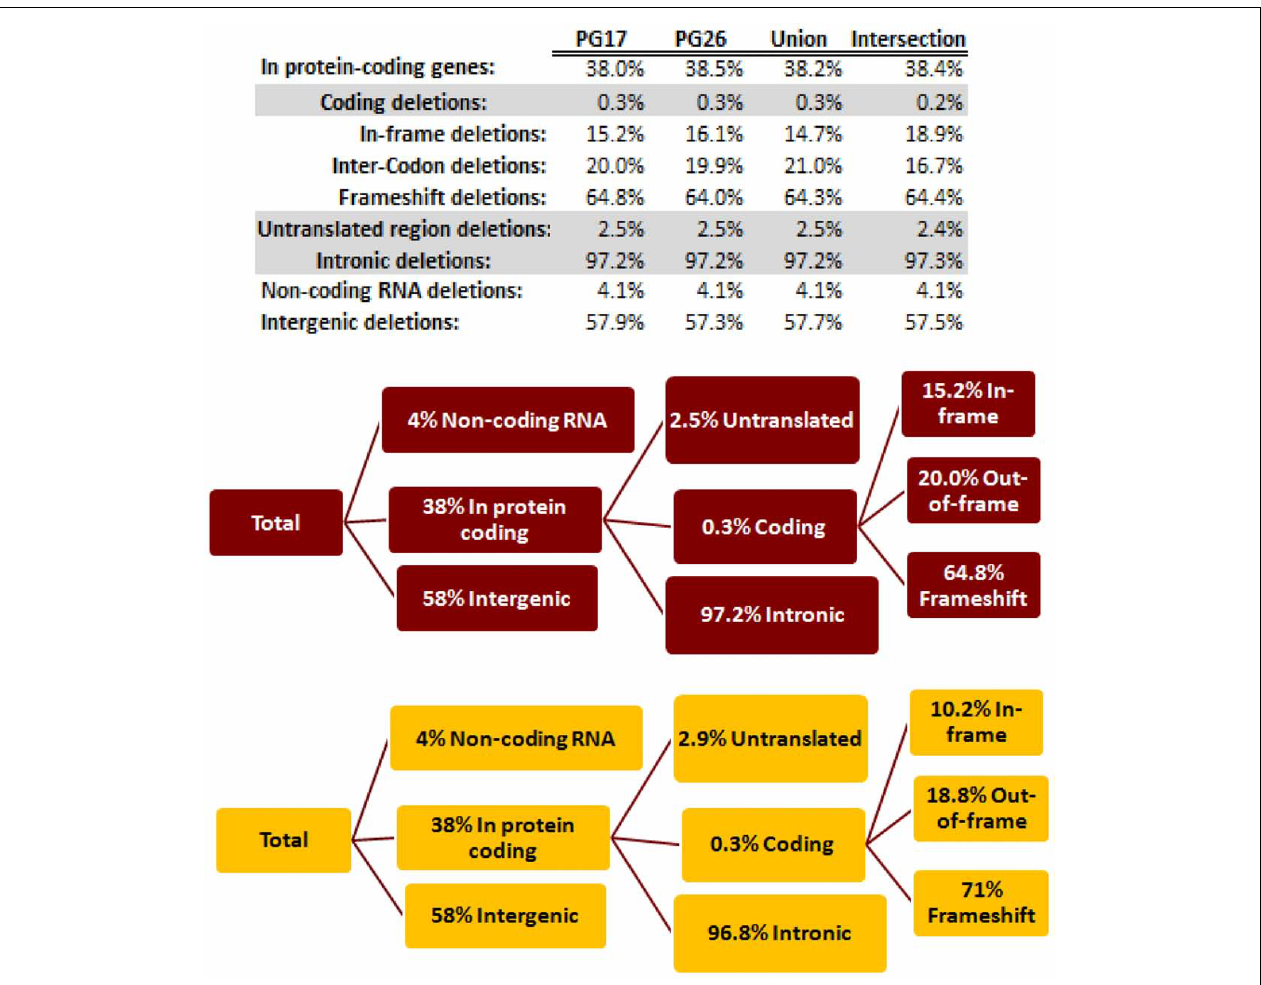
FIGUREA9 | Functional analysis of the deletions detected in PG17 and PG26, their union and intersection. The chart in maroon shows the breakdown of deletions and the rate of coding deletions in PG17 and PG26.The chart in orange shows the summary of deletions in nine whole genomes generated from complete genomics and annotated in the same way as PG17 and